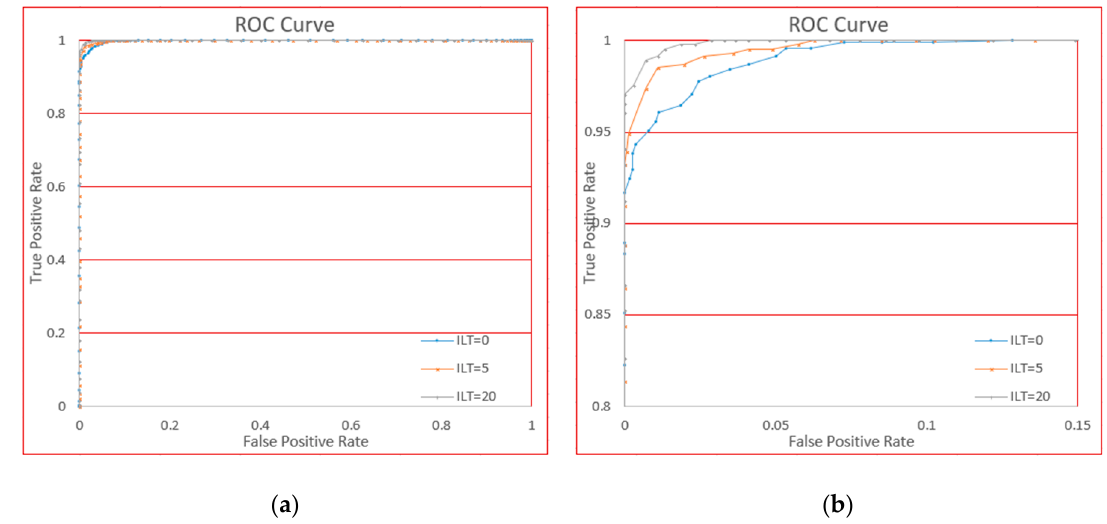
Figure 20. The ROC curve for different incremental learning times (ILT). ( a ) Is the global view and ( b ) is the local view for clarity.